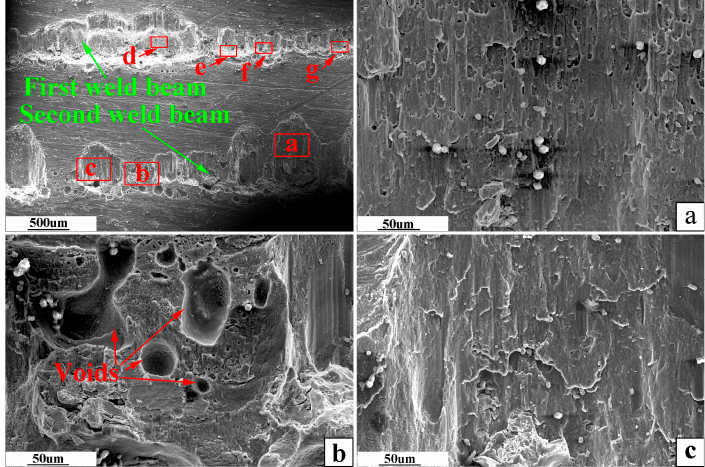
Figure 13. SEM image of the selected area of the fracture surface on the aluminum side. ( a – c ) are partially enlarged views of the same red-framed marked area in the upper left picture.